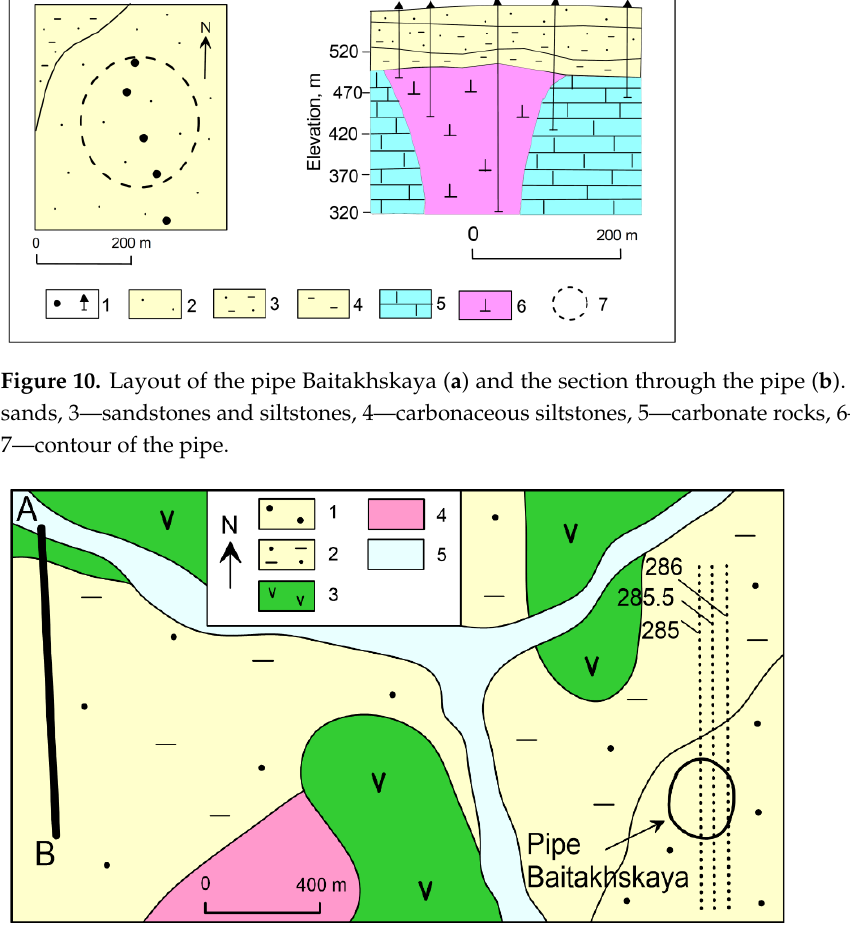
Figure 11. Scheme of location of the source AB and profiles at the kimberlite pipe Baitakhskaya. 1 — sands, 2 — sandstones and siltstones, 3 — dolerites, 4 — tuffs, 5 — river and Quaternary sediments.